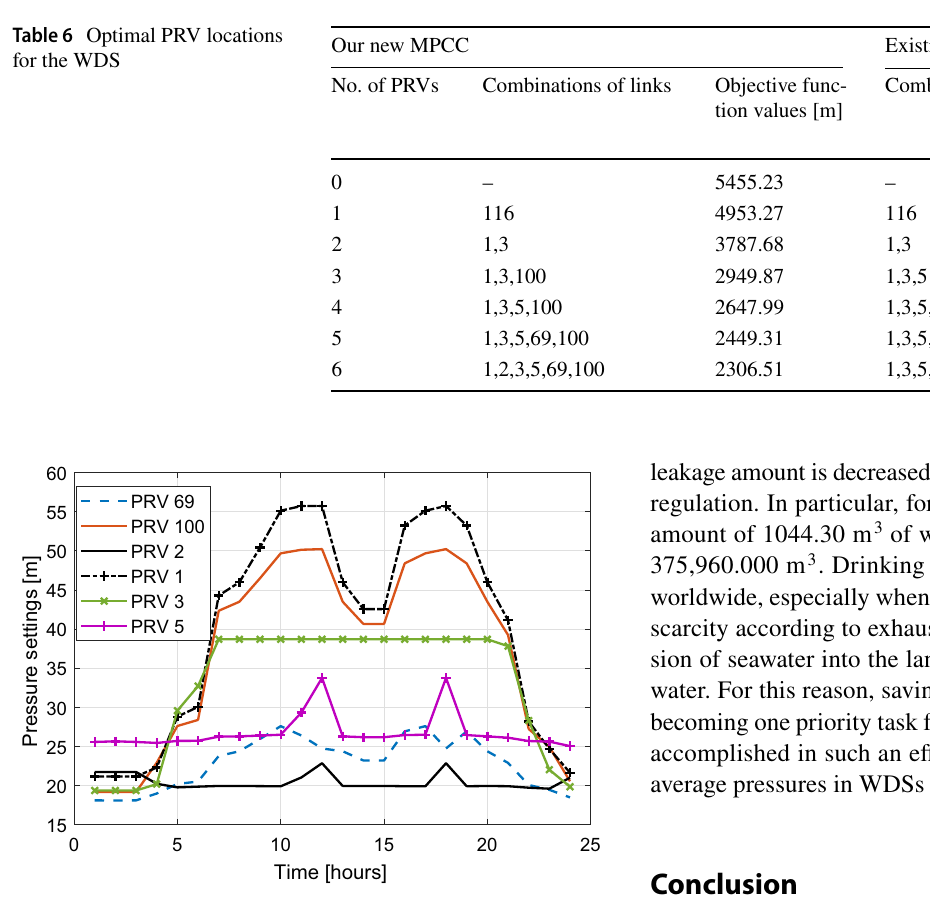
Fig. 13 Pressure settings of 6